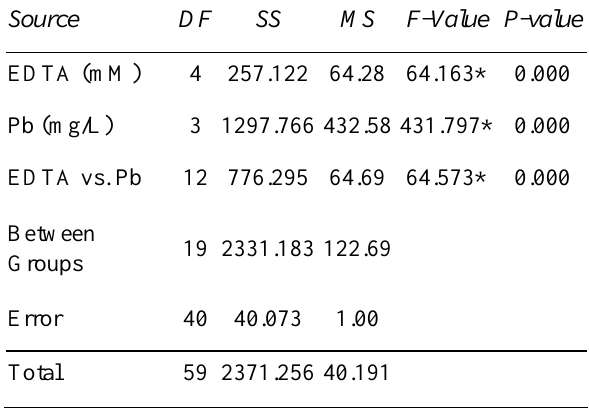
Table 3: Effects of Pb and EDTA concentrations on leaf net photosynthetic rate (µmol CO lacunosa L. leaves (two-way ANOVA with